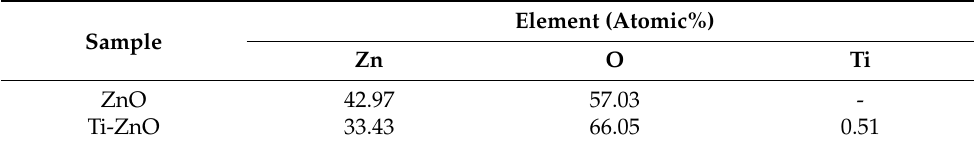
Figure 4. Particle size distribution of ( a ) ZnO and ( b ) Ti-ZnO NPs. Table 1. Detected chemical composition of ZnO and Ti-ZnO using EDS.